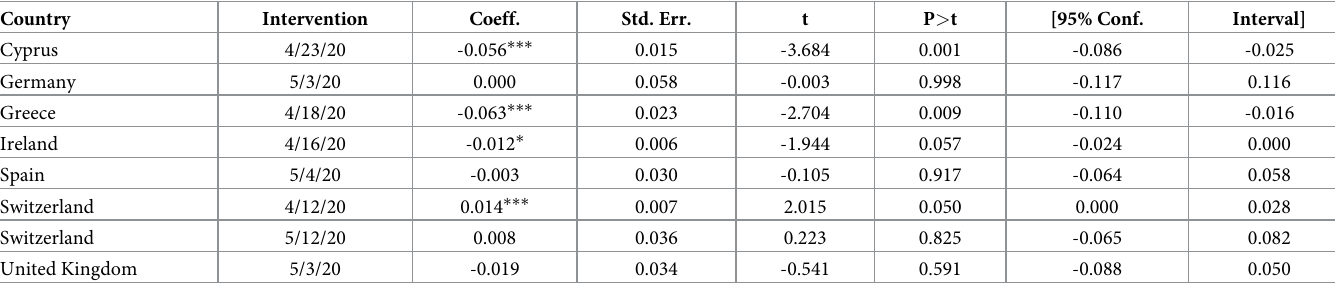
Pandemic fatigue could be considered as one of the different possible explanations in cer- tain cases [35, 36] but this phenomenon cannot provide a single answer for all the countries Table 2. Post-interventions linear trend with (decreasing) COVID-19 cases. Country Intervention Coeff. Std. Err. P >